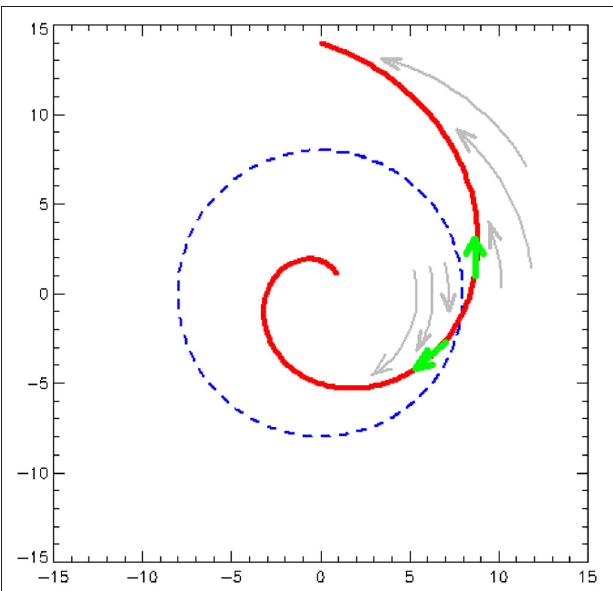
FIGURE 8 | A schematic model for the Galactic gas gap. A spiral arm is represented in red, it is a groove in the gravitational potential of the disk, which acts like a river for the interstellar gas. Due to the rigid body-like rotation of the spiral arm, and to the flat rotation curve of the Galaxy, the interstellar gas which is being swept, represented by gray arrows, penetrates the arms from opposite sides in the inner and outer regions of the disk, the frontier being the corotation radius, represented by the dashed blue circle. The angle of penetration of the gas determines the direction of the gas flow inside the arm. This results in opposite flow direction indicated by green arrows on the two sides of the corotation circle, a phenomenon which decreases the gas density in the arms near the corotation